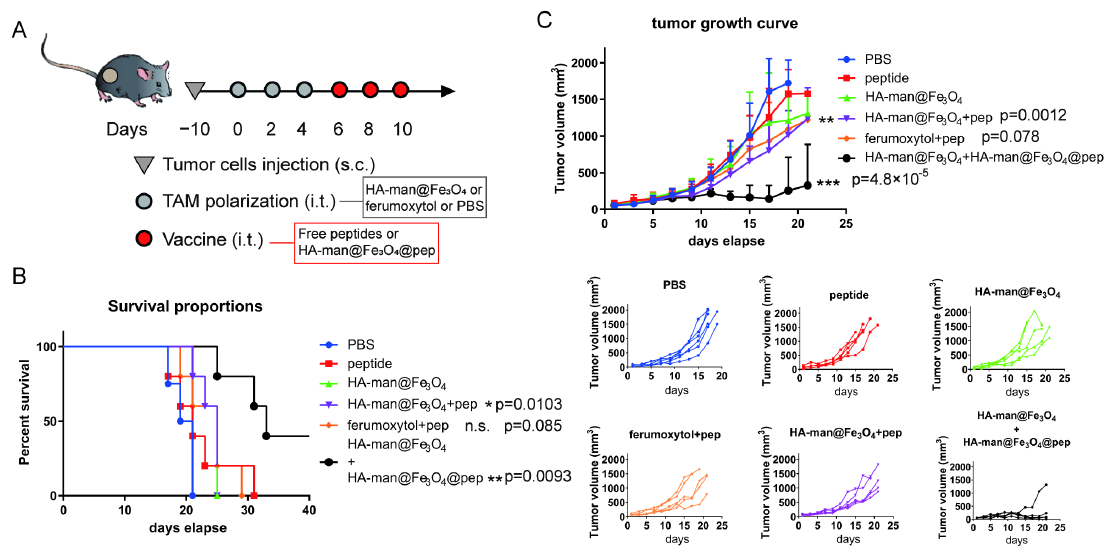
Figure 6. TC1 tumor inhabitation in vivo. ( A ) Scheme displaying the time schedule of the tumor implantation and treatment of C57 mice; ( B ) survival curves posttreatment; ( C ) average tumor growth curves and individual tumor growth curves posttreatment. Mice were treated with 20 mg kg −1 iron oxides in Fe and 2 mg kg −1 peptide per dose. Equal amount was achieved in HA- man@Fe 3 O 4 @pep. p -value has been calculated by the one-way ANOVA test. ** p < 0.01, and *** p < 0.001. 3.8. TAM Repolarization and Enhanced T Cell Infiltration into Tumor To investigate TAM repolarization in the TME, tumor tissues from various treatment groups were collected and analyzed by flow cytometry. CD206 expression in macro- phages decreased following HA-man@Fe 3 O 4 treatment (Figure 7A,D). Combination ther- apy with HA-man@Fe 3 O 4 @pep further decreased its expression in the TME. Consistent with CD206 expression, CD86 expression in macrophages was elevated by HA- man@Fe 3 O 4 and was further enhanced when combined with HA-man@Fe 3 O 4 @pep (Figure 7B,E). This enhanced polarization effect might be attributable to two reasons: (1) the iron particles further strengthened the polarization effect; and (2) the nanocomplex stimulated macrophages to be involved in the immune response. Compared with the peptide and HA-man@Fe 3 O 4 groups, the HA-man@Fe 3 O 4 + peptide group enhanced macrophage po- larization. This might indicate that antigen stimulation plays an important role in macro- phage polarization. We analyzed the total RNA of tumor tissue by RT-qPCR to confirm the repolarization effect. The expression of M1-related markers was remarkably